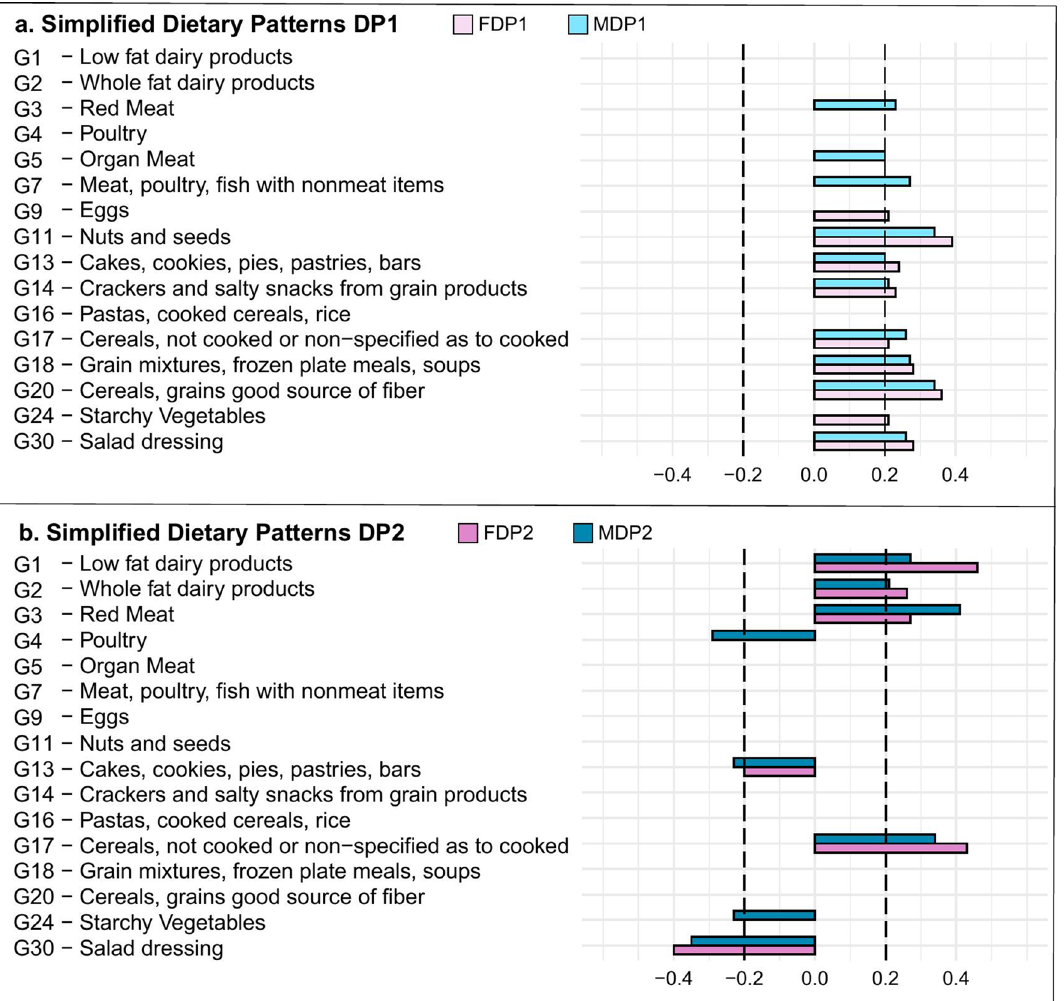
Figure 2. Simplifed Dietary Patterns. RRR loading factors above 0.2 or below − 0.2 shown for each subgroup. ( a ) Simplified dietary patterns 1 for female (FDP1) (light pink) and male (MDP1) (light blue). ( b ) Simplified dietary patterns 2 for female (FDP2) (dark pink) and male (MDP2) (dark blue).